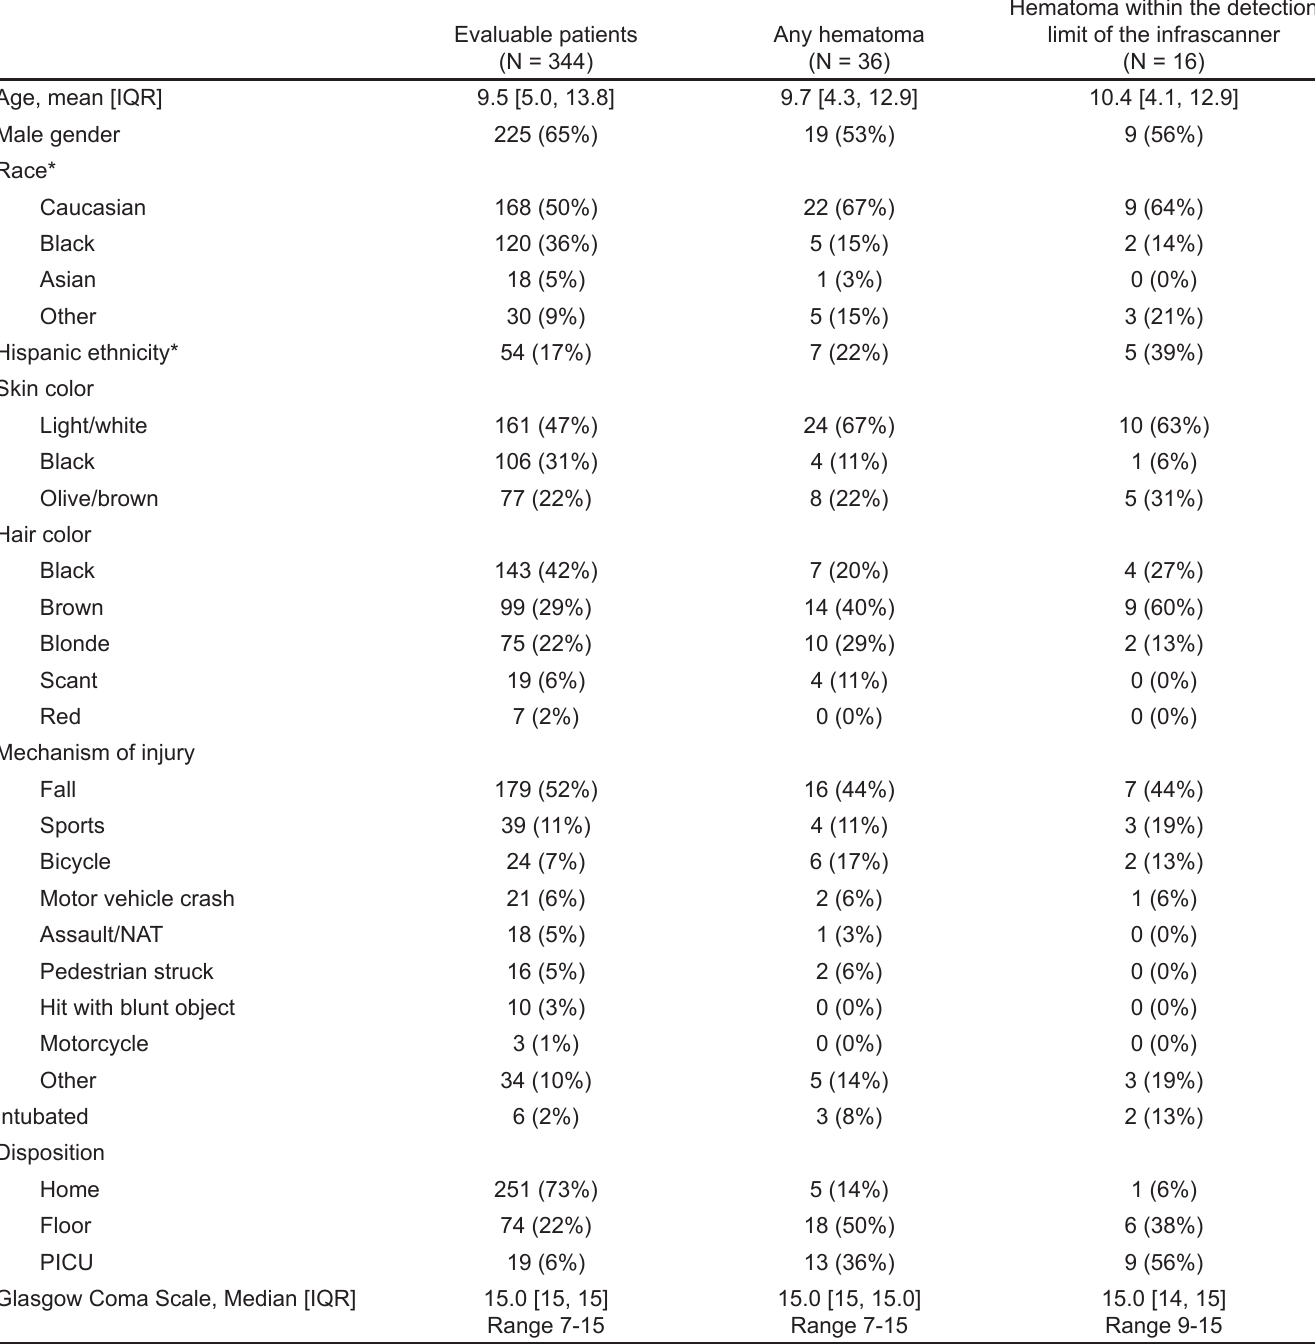
Table 1. Patient and clinical